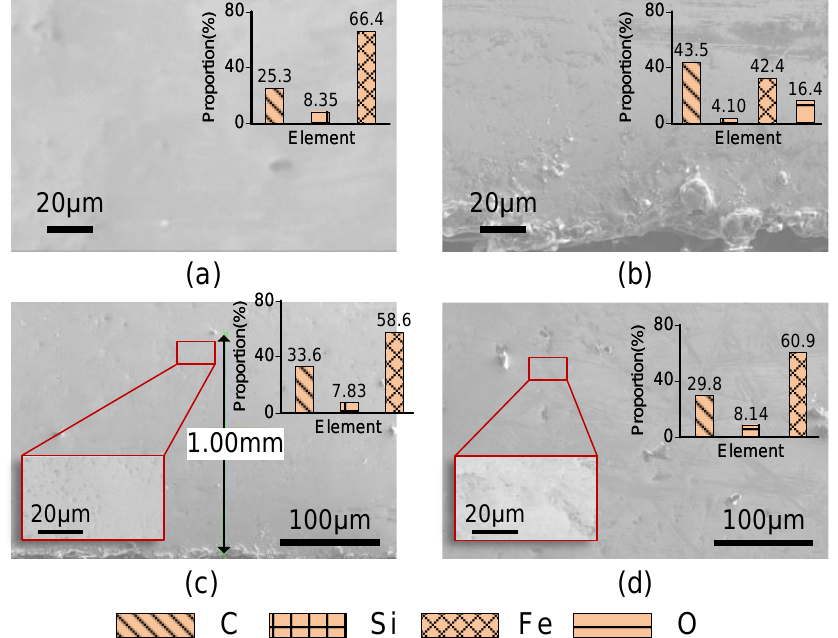
Figure 12. SEM and EDS results of AA ribbons. ( a ) Original ribbon; ( b ) edge of W-EDM-processed sample; ( c ) affected area of the processed sample; ( d ) unaffected area of the processed